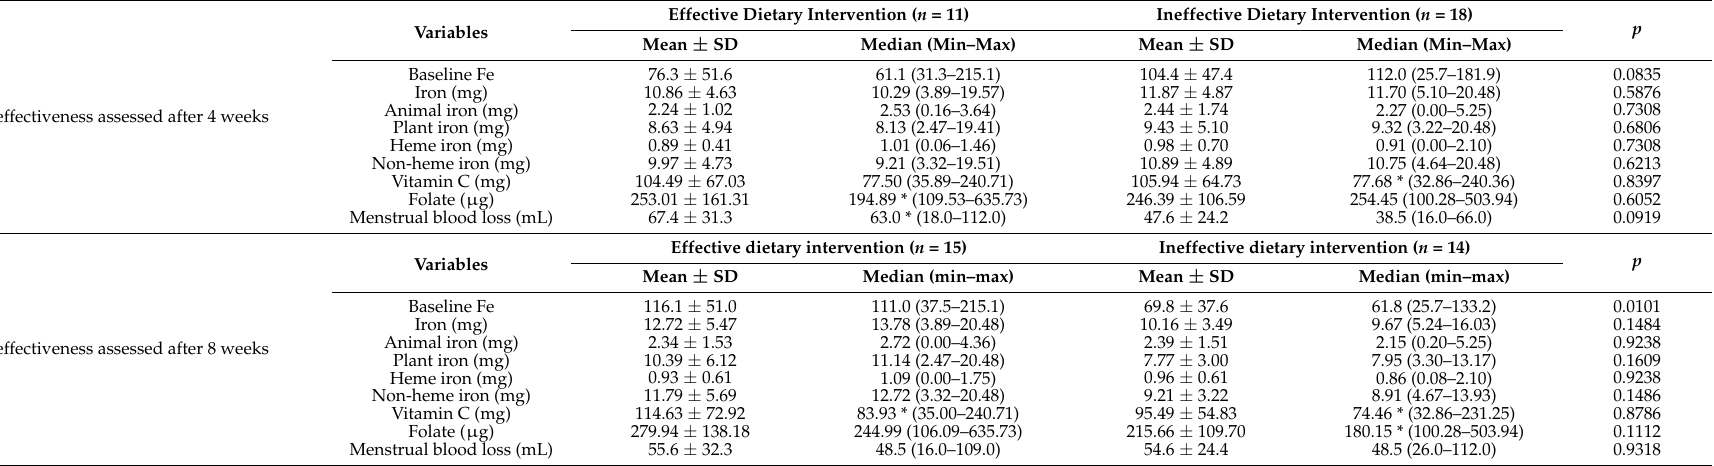
Table 7. The comparison of the baseline characteristics of the subsamples (iron level, dietary intake, and menstrual blood loss) in subsamples stratified by the effectiveness of dietary intervention assessed for serum iron level after 4 and 8